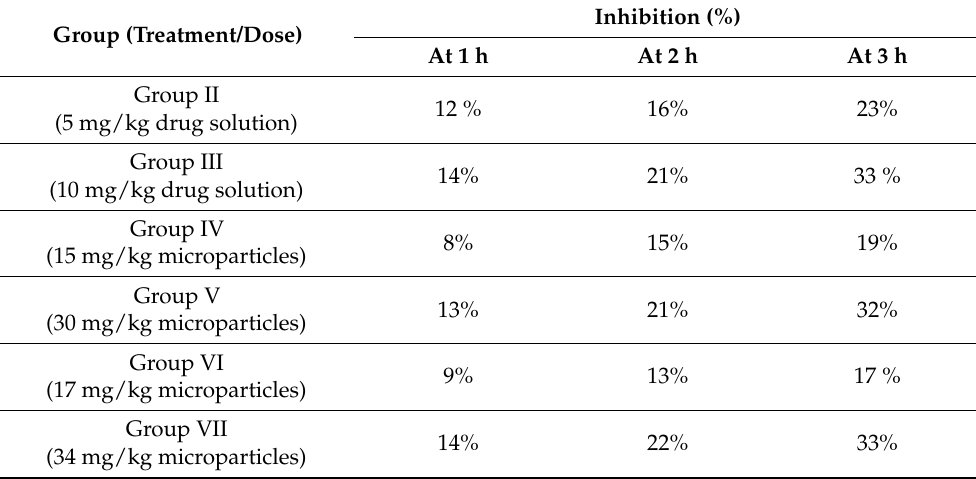
Table 4. Percentage (%) inhibition of carrageenan-induced paw edema in rats at 1 h, 2 h, and 3 h. Group